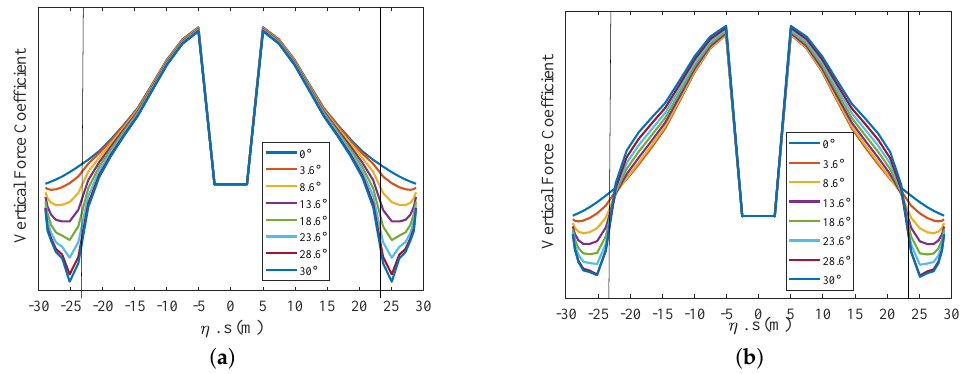
Figure 4. Wingtip folding angle Γ wt effect on AX-1 vertical force coefficient with a flared hinge: ( a ) 20% wing semispan wingtip—rigid; and ( b ) 20% wing semispan